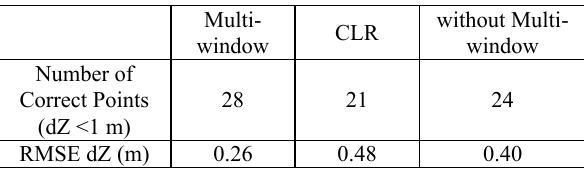
Figure 4. Feature Extraction